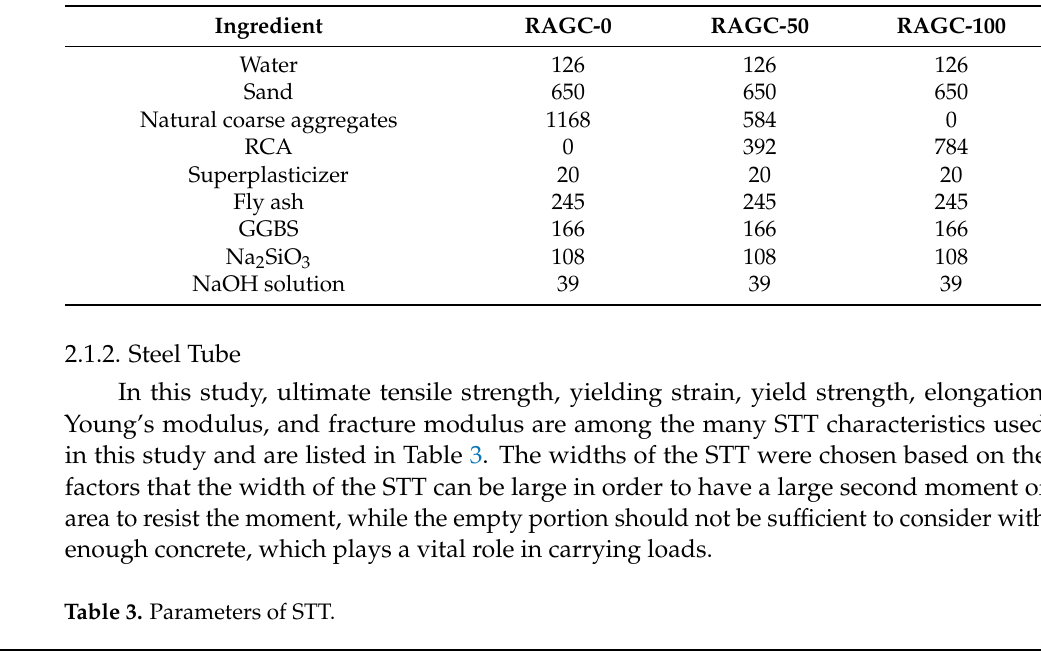
Table 3. Parameters of